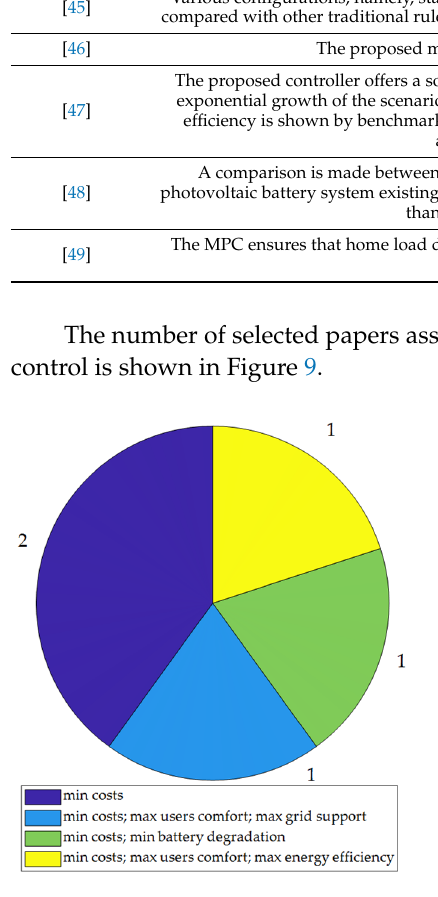
Table 13. Findings of selected papers associated with model predictive control.